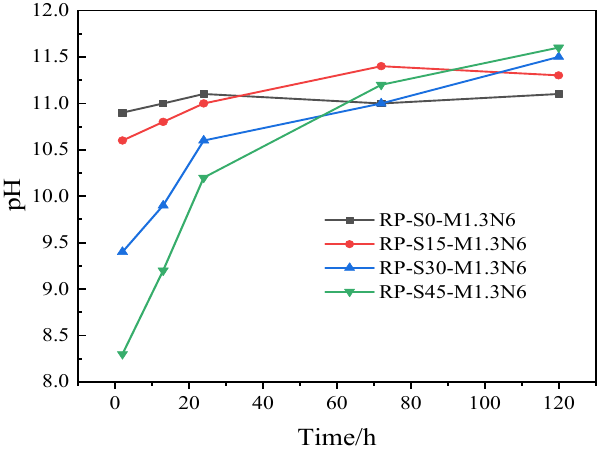
Figure 14. PH values of RPSG with different slag contents.